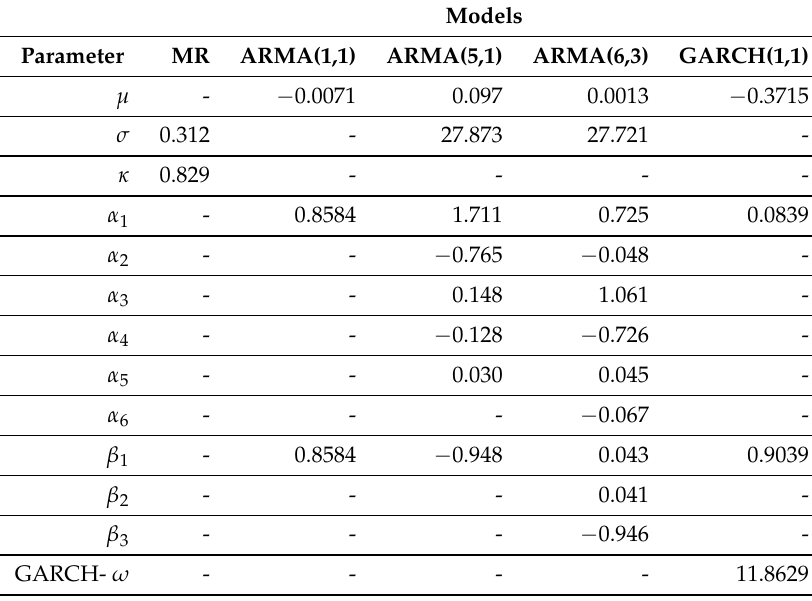
Table 4. Model parameters.